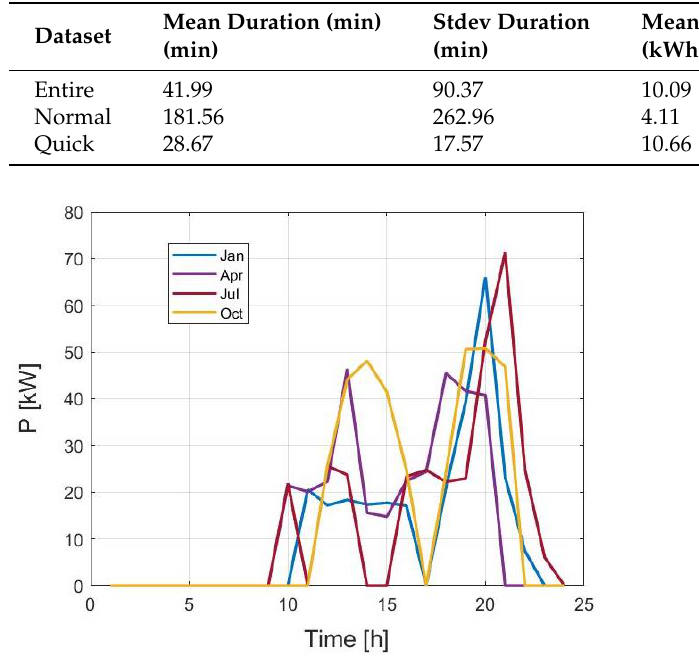
Figure 2. Examples of synthetic load profiles for Barcelona for some months of the